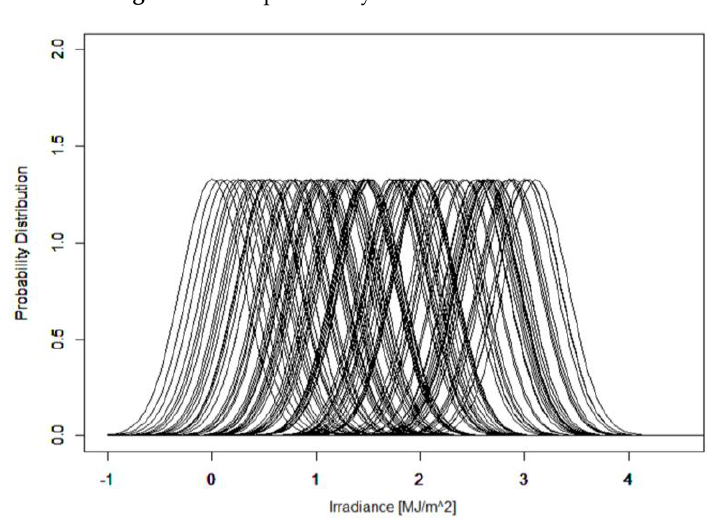
Figure 8. Probability distribution of the irradiance given that the solar output is 4.9 MW.